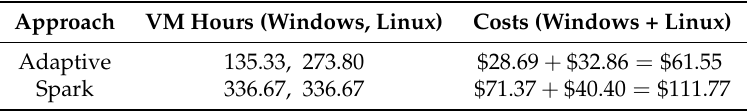
Table 6. Costs of different approaches on Microsoft